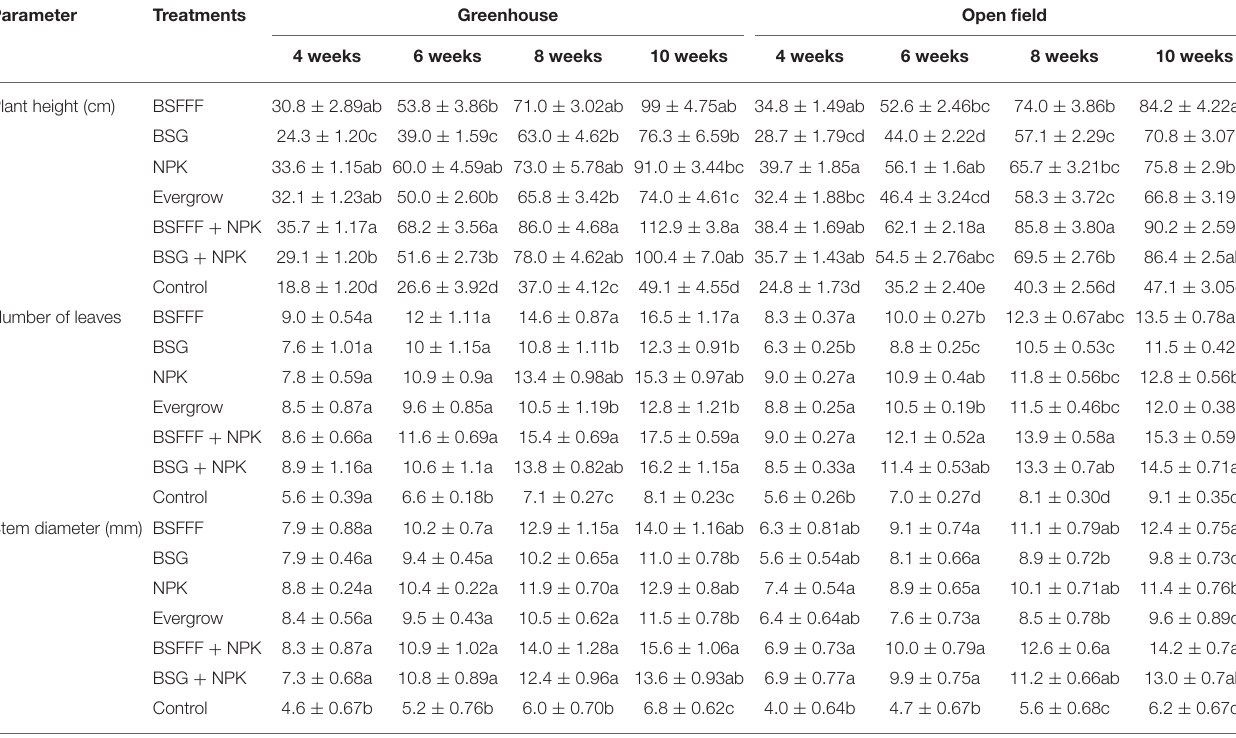
TABLE 3 | Effect of composted BSF frass, conventionally composted BSG, and commercial fertilizers on the growth of tomatoes. Parameter